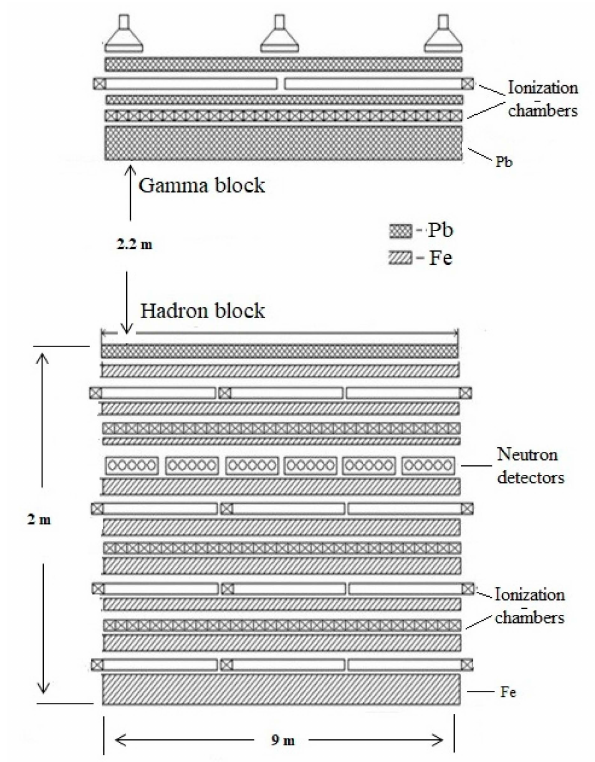
Figure 4. Scheme of the ionization-neutron calorimeter.